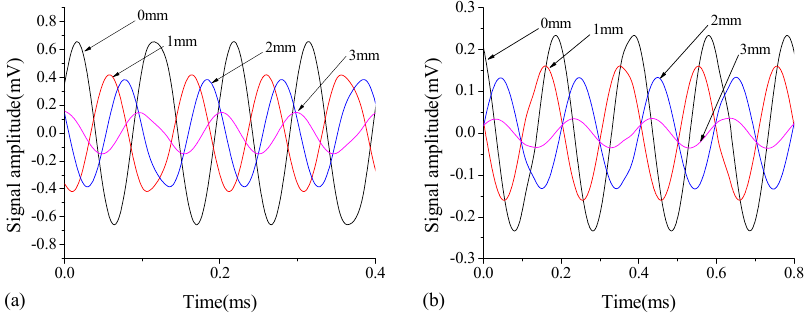
Figure 11. The receiver voltage of the output signals for ( a ) B-type steel-UHPC specimen and ( b ) C-type steel-NSC specimen with different debonding defects in thickness.